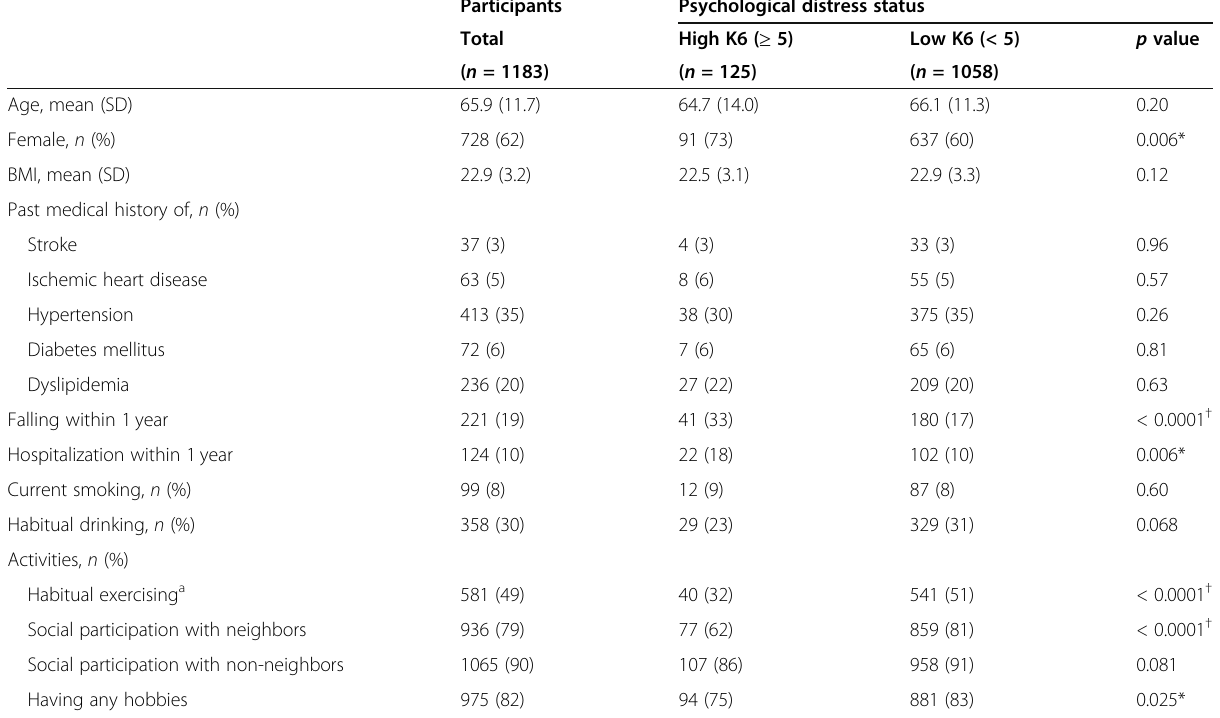
Table 1 Comparisons of demographic variables between the K6 high group and the K6 low